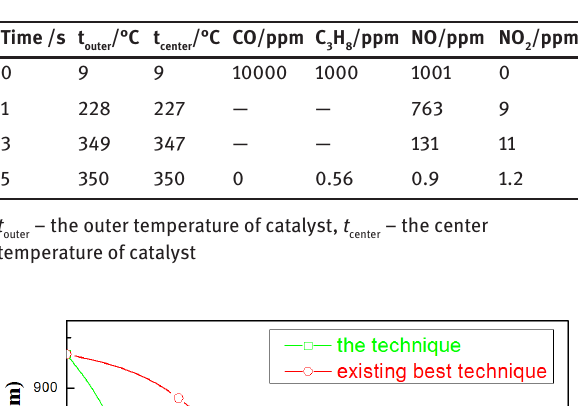
Table 2: Residual concentration of simulated exhaust gases over optimized catalyst with high-frequency electrical heating.